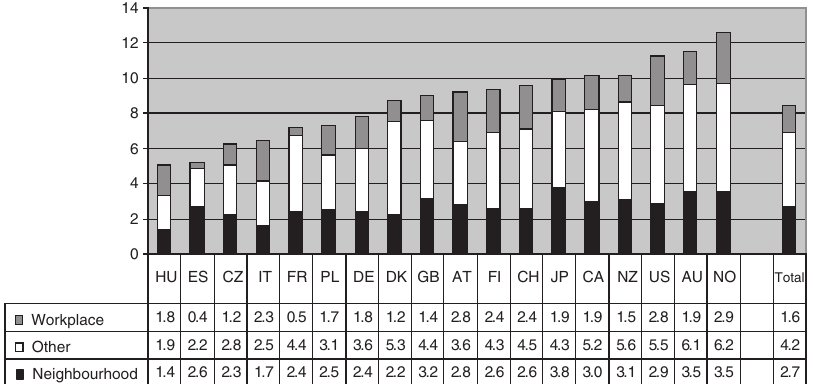
Figure 5. A v erage number of close friends by type and